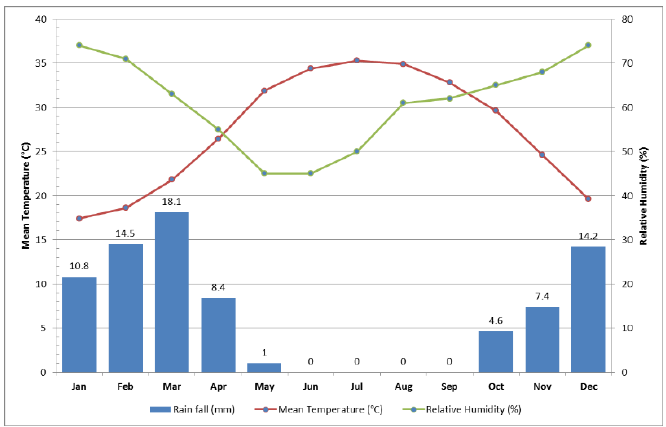
Figure 1. Qatar monthly average rainfall, mean temperature and relative humidity (QMD,